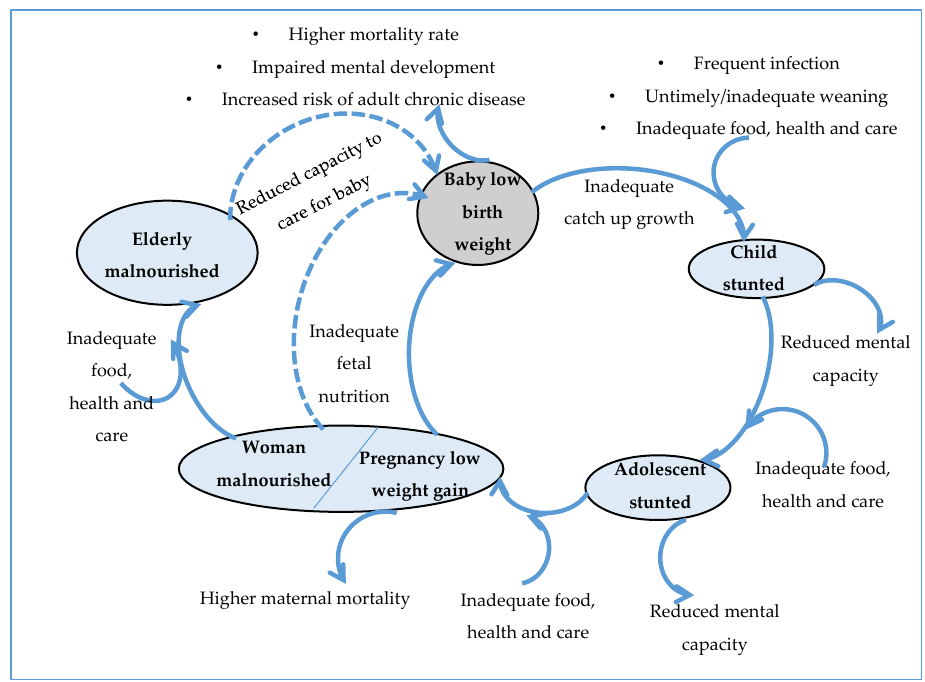
Figure 1. Nutrition throughout the life cycle showing the effect of malnutrition on the adolescent girl and her unborn child [12].